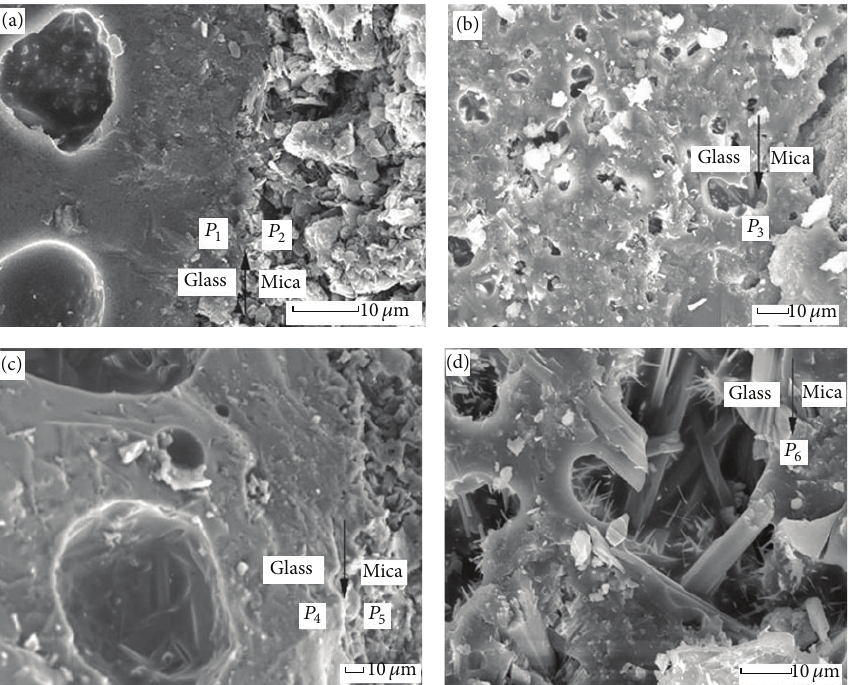
Figure 5: Microstructures of the interface in sandwich samples isothermally heated at 820 ∘ C for (a) 0 and (b) 2 h and at 900 ∘ C for (c) 0 and (d) 2h.